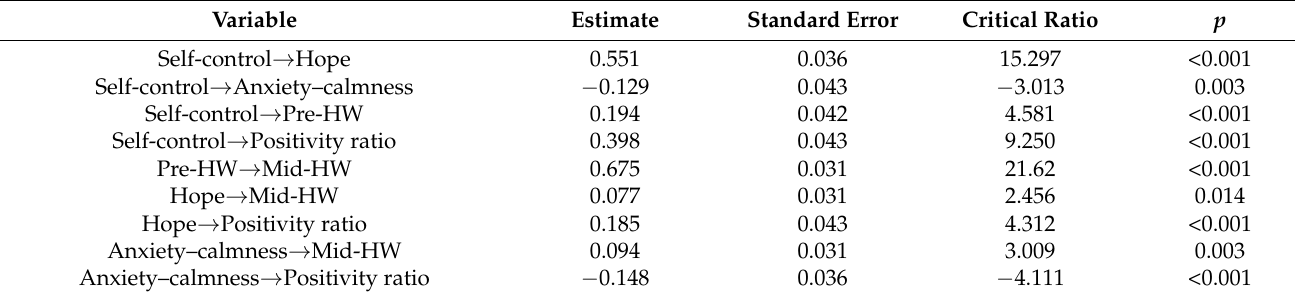
Table 2. Estimated regression weights ( n =